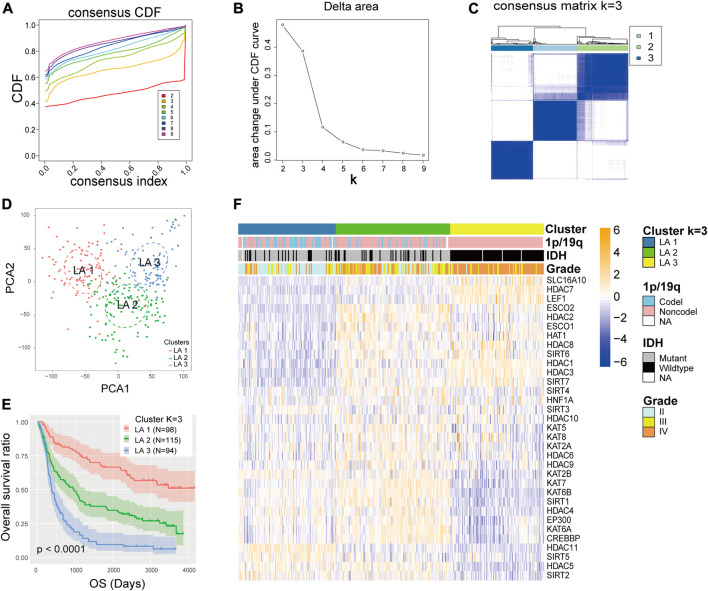

(A) Consensus clustering cumulative distribution function (CDF) for k = 2 to 9. (B) Relative change in area under the CDF curve for k = 2 to 9. (C) Consensus clustering matrix for k = 3. (D) Principal component analysis of the total RNA expression profile in the CGGA dataset. (E) Kaplan–Meier overall survival curves for 307 glioma patients in the LA1, 2, and three subgroups. (F) The different expression levels of lysine acetylation regulators (LARs) and clinicopathological feature contributions of the three subgroups defined by the consensus expression of 33 LARs.